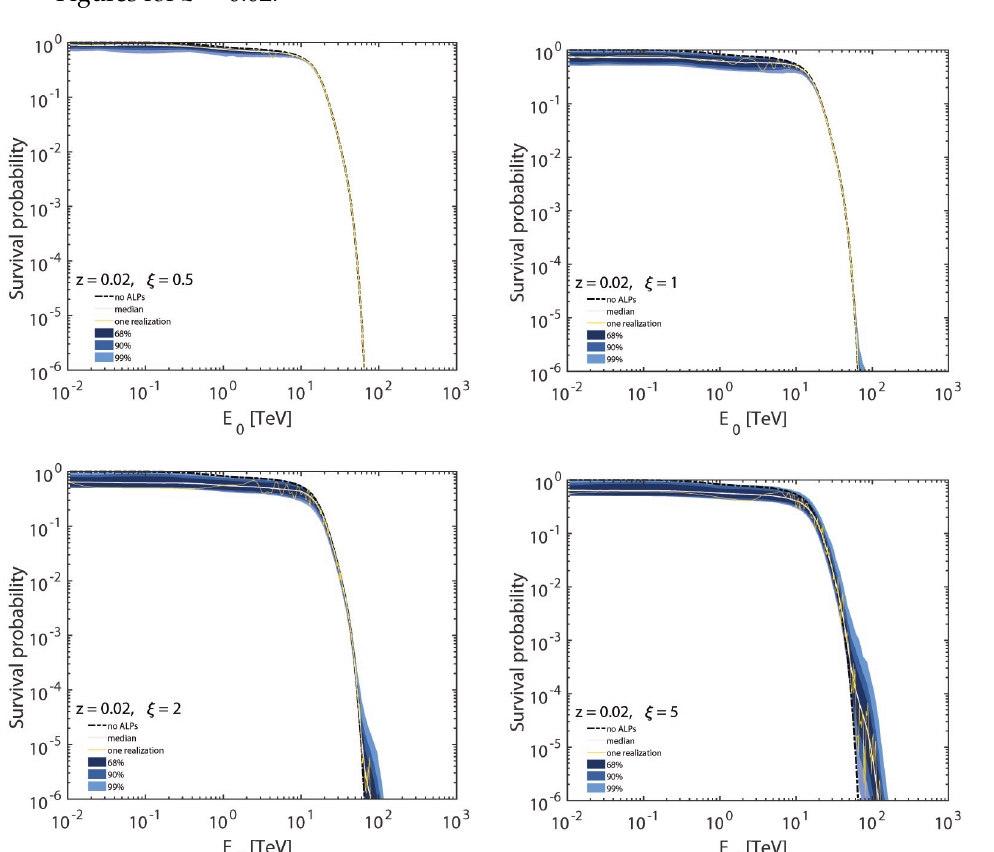
Figure 17. Behaviour of P ALP γ → γ ( E 0 , z ) versus the observed energy E 0 for z = 0.02. In all the figures we have taken a random distribution of the domain length L dom : we have chosen a power law distribution function as described in the text. We take a smoothing parameter with σ = 0.2 for the transition from one magnetic field domain to the following one. The dotted-dashed black line corresponds to conventional physics, the solid light-gray line to the median of all the realizations of the propagation process and the solid yellow line to a single realization with a random distribution of the domain lengths and of the orientation angles of the magnetic field inside the domains. The filled area is the envelope of the results on the percentile of all the possible realizations of the propagation process at 68% (dark blue), 90% (blue) and 99% (light blue), respectively. In the upper-left panel we have chosen ξ = 0.5, in the upper-right panel ξ = 1, in the lower-left panel ξ = 2 and in the lower-right panel ξ = 5. (Credit